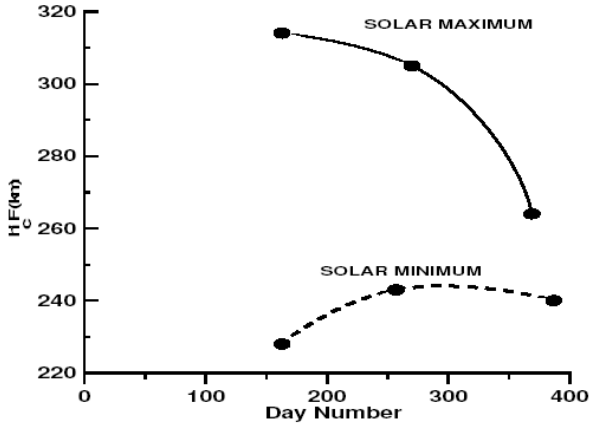
Fig. 4. The seasonal variation in threshold height for solar minimum (dashed) and maximum (solid)